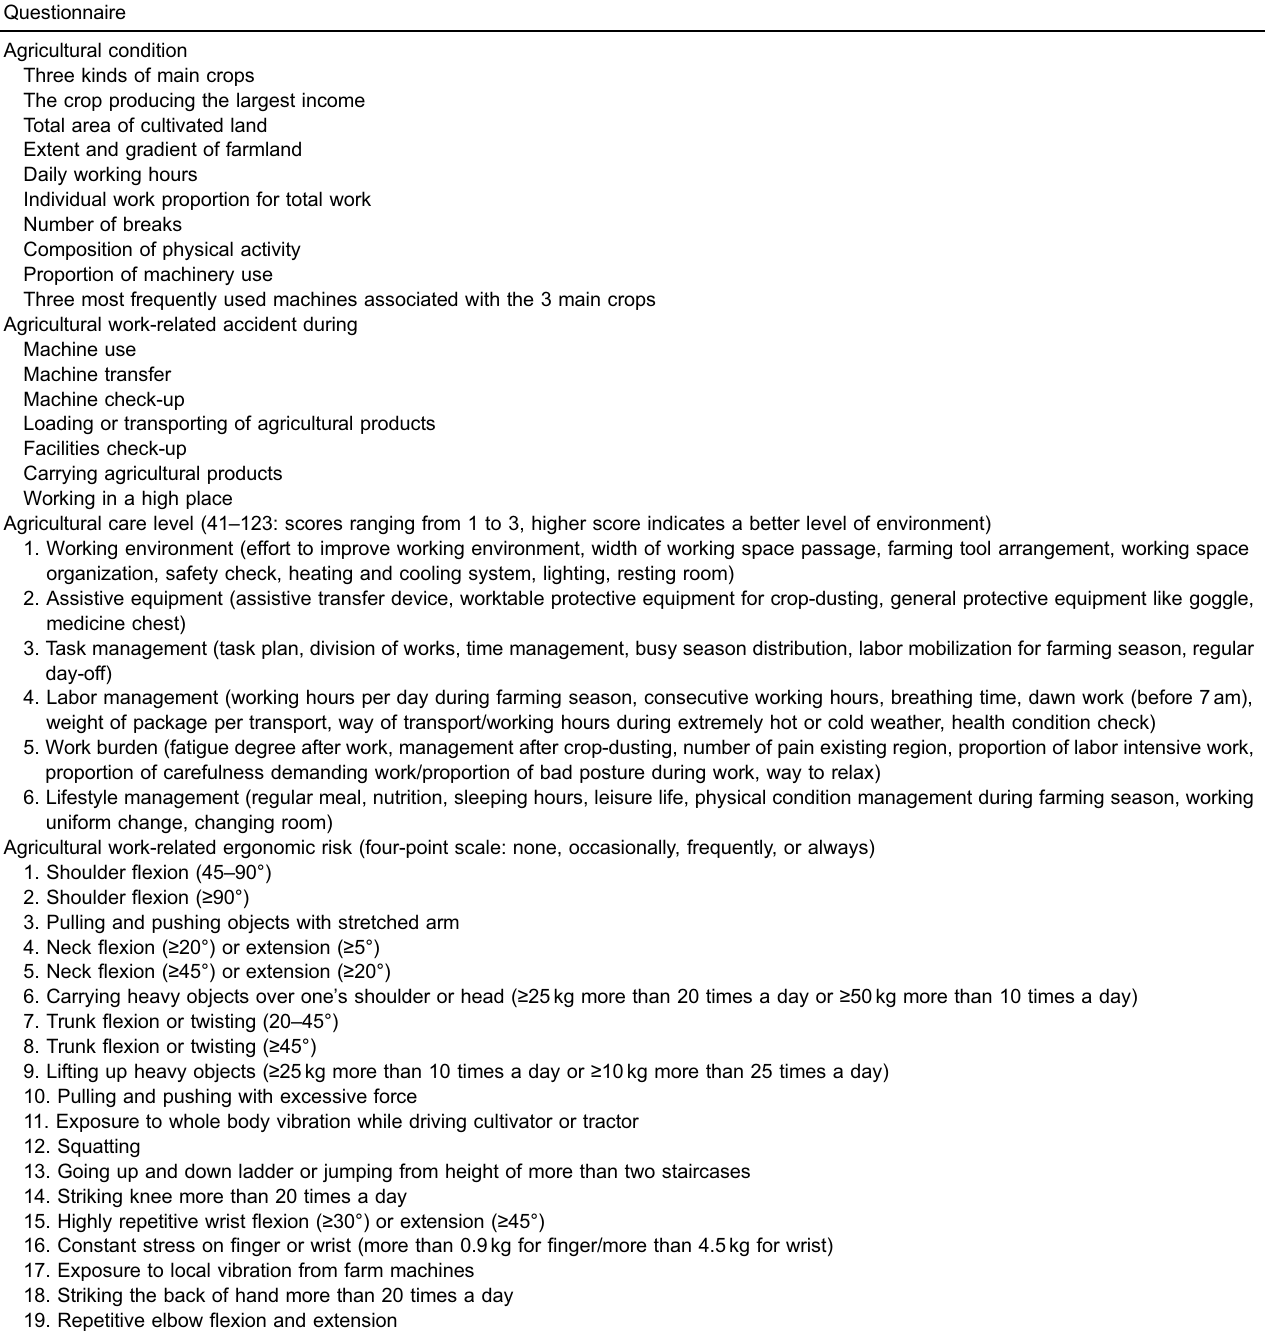
Table 2. Evaluated questionnaires for agricultural work-related factors Questionnaire Agricultural condition Three kinds of main crops The crop producing the largest income Total area of cultivated land Extent and gradient of farmland Daily working